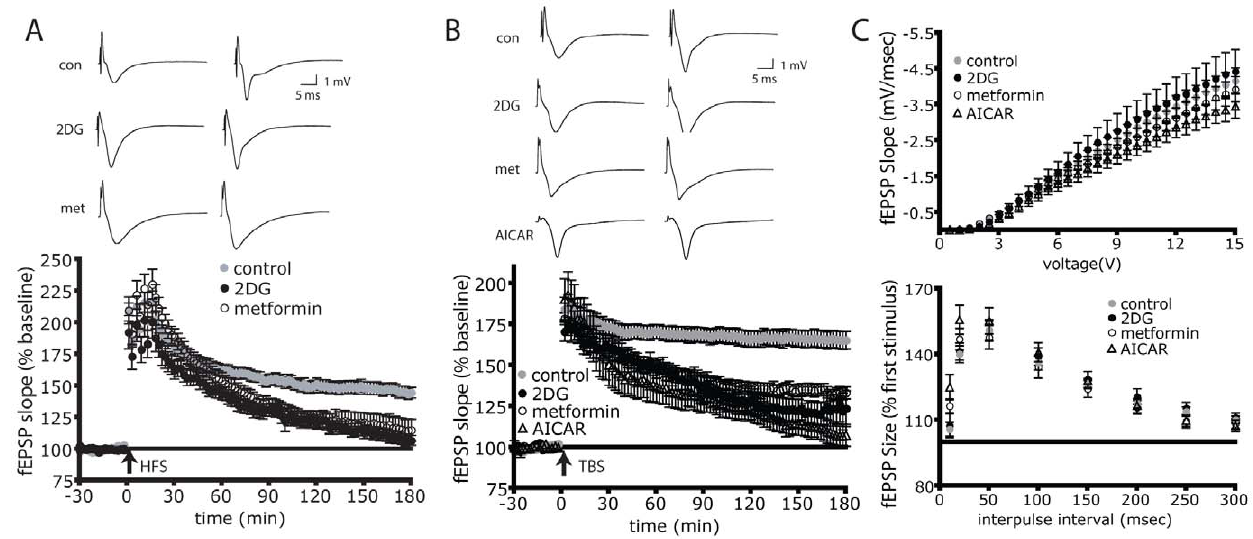
Figure 3. AMPK activation inhibits L-LTP expression. A) AMPK activation inhibits LTP induced by HFS. 10 mM 2DG (n=10) reduces L-LTP to 10% of control (n=20) (p=0.034). 5 m M metformin (n=8) reduces L-LTP to 40% of control (p=0.028). B) AMPK activation inhibits LTP induced by TBS. 10 mM 2DG reduces L-LTP (p=0.022, n=7) to 30% of control (n=13), 5 m M metformin reduces L-LTP (p=0.042, n=12) to 51% of control. 1 mM AICAR reduces L-LTP (p=0.0025, n=8) to 11% of control C) 2DG, metformin and AICAR do not have an effect on basic synaptic transmission. Top: input-output relationships for Schaeffer collateral stimulation and fEPSP slope measured in the presence of ACSF (n=27), 10 mM 2DG (n=14), 5 m M metformin (n=17) or 1 mM AICAR (n=8). Bottom: Paired Pulse Facilitation is not affected by the presence of 10 mM 2DG (n=11), 5 m M metformin (n=17) or 1 mM AICAR (n=8) compared to ACSF alone (n=14). Results are plotted as the ratio of fEPSP slopes (2 nd stimulus/1 st stimulus X100) as a function of interpulse interval (0–300 msec). *p=0.0002. A and B) Inset: representative fEPSP traces shown were taken 4 minutes prior and 180 minutes after stimulation. Error bars show s.e.m.